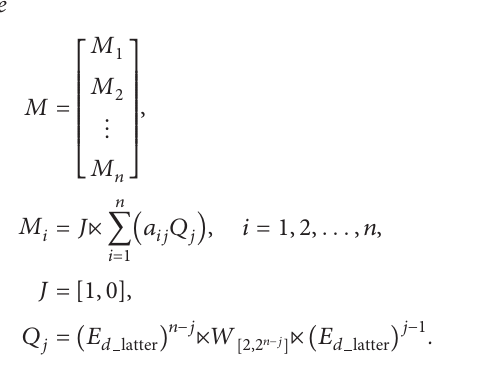
Algorithm 1. For a given graph G � ( V, E ) , let A � [ a ij ] be the UAM of G , and assign each v i ∈ V a two-valued variable x D � 0 , 1 i ∈